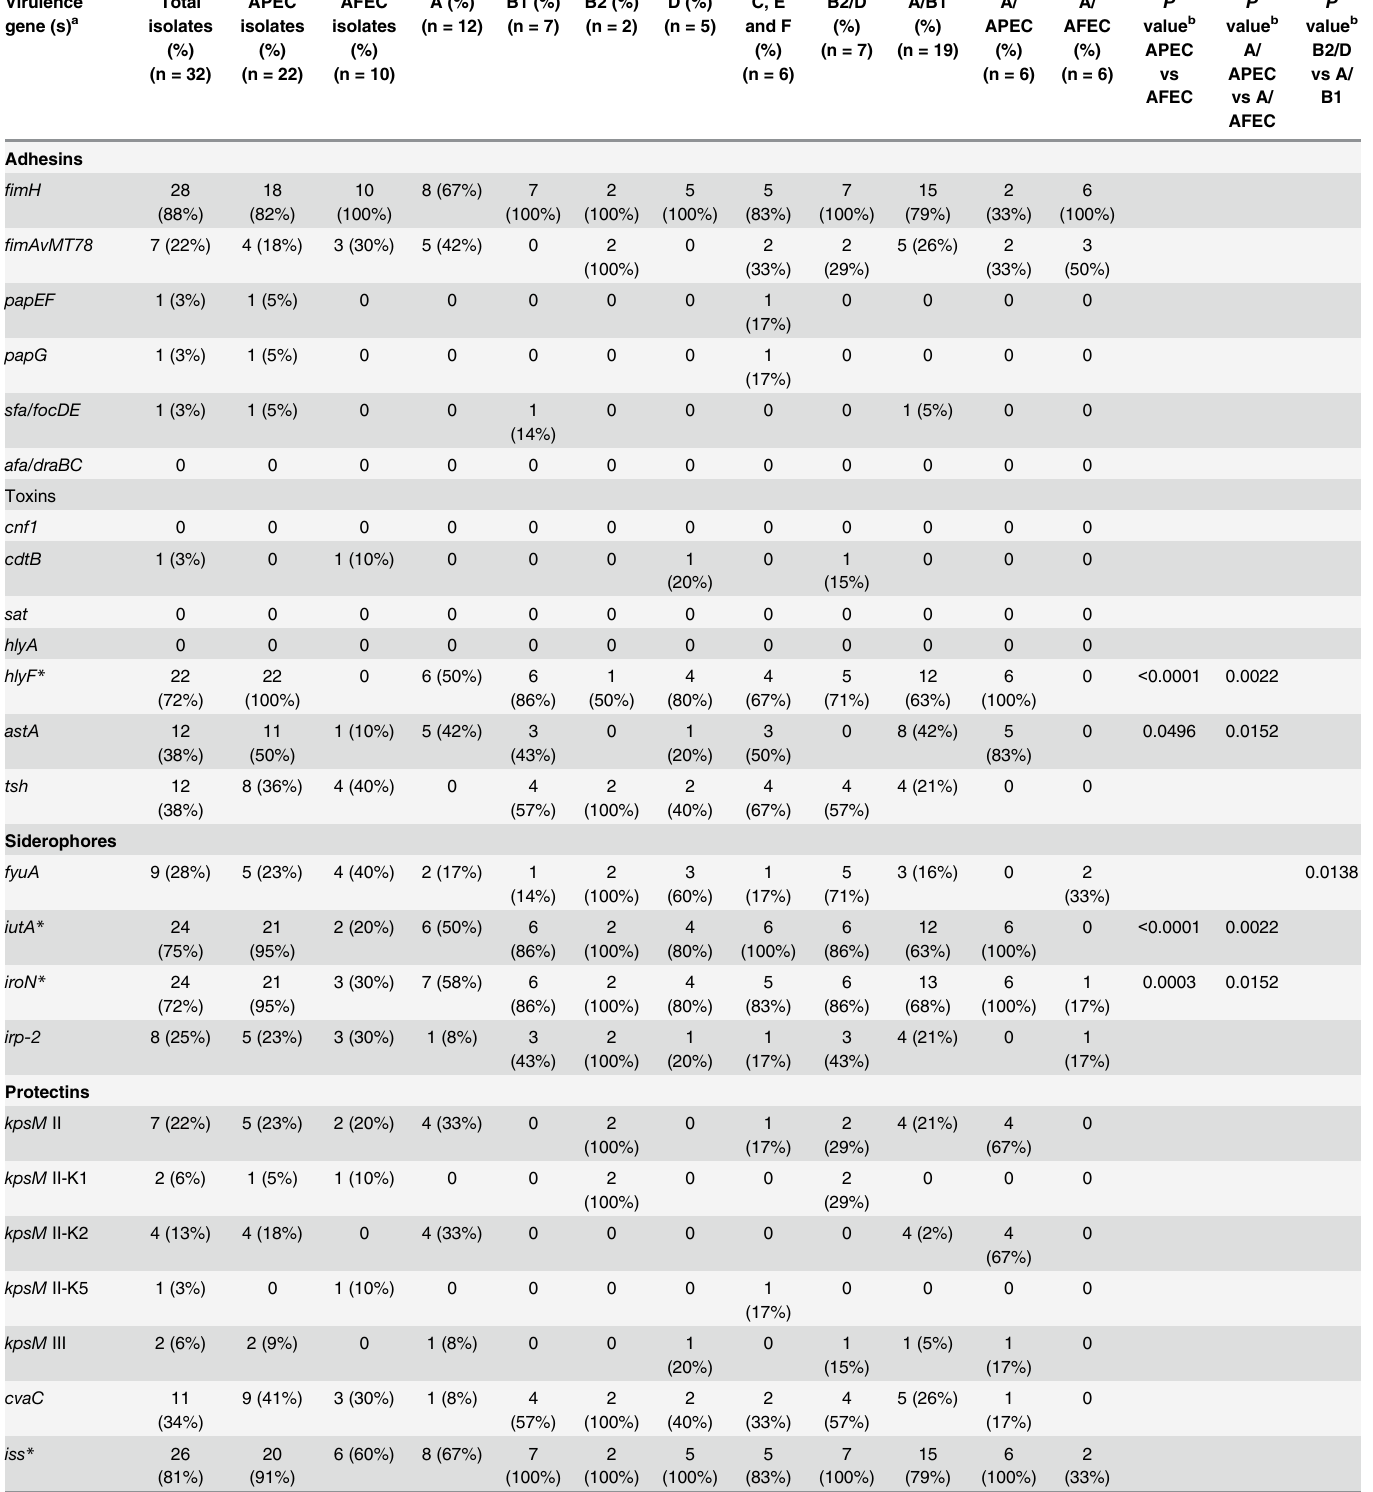
Table 2. Distribution and characterization of virulence-associated genes and phylogroups of the 32 isolates. Virulence gene (s)